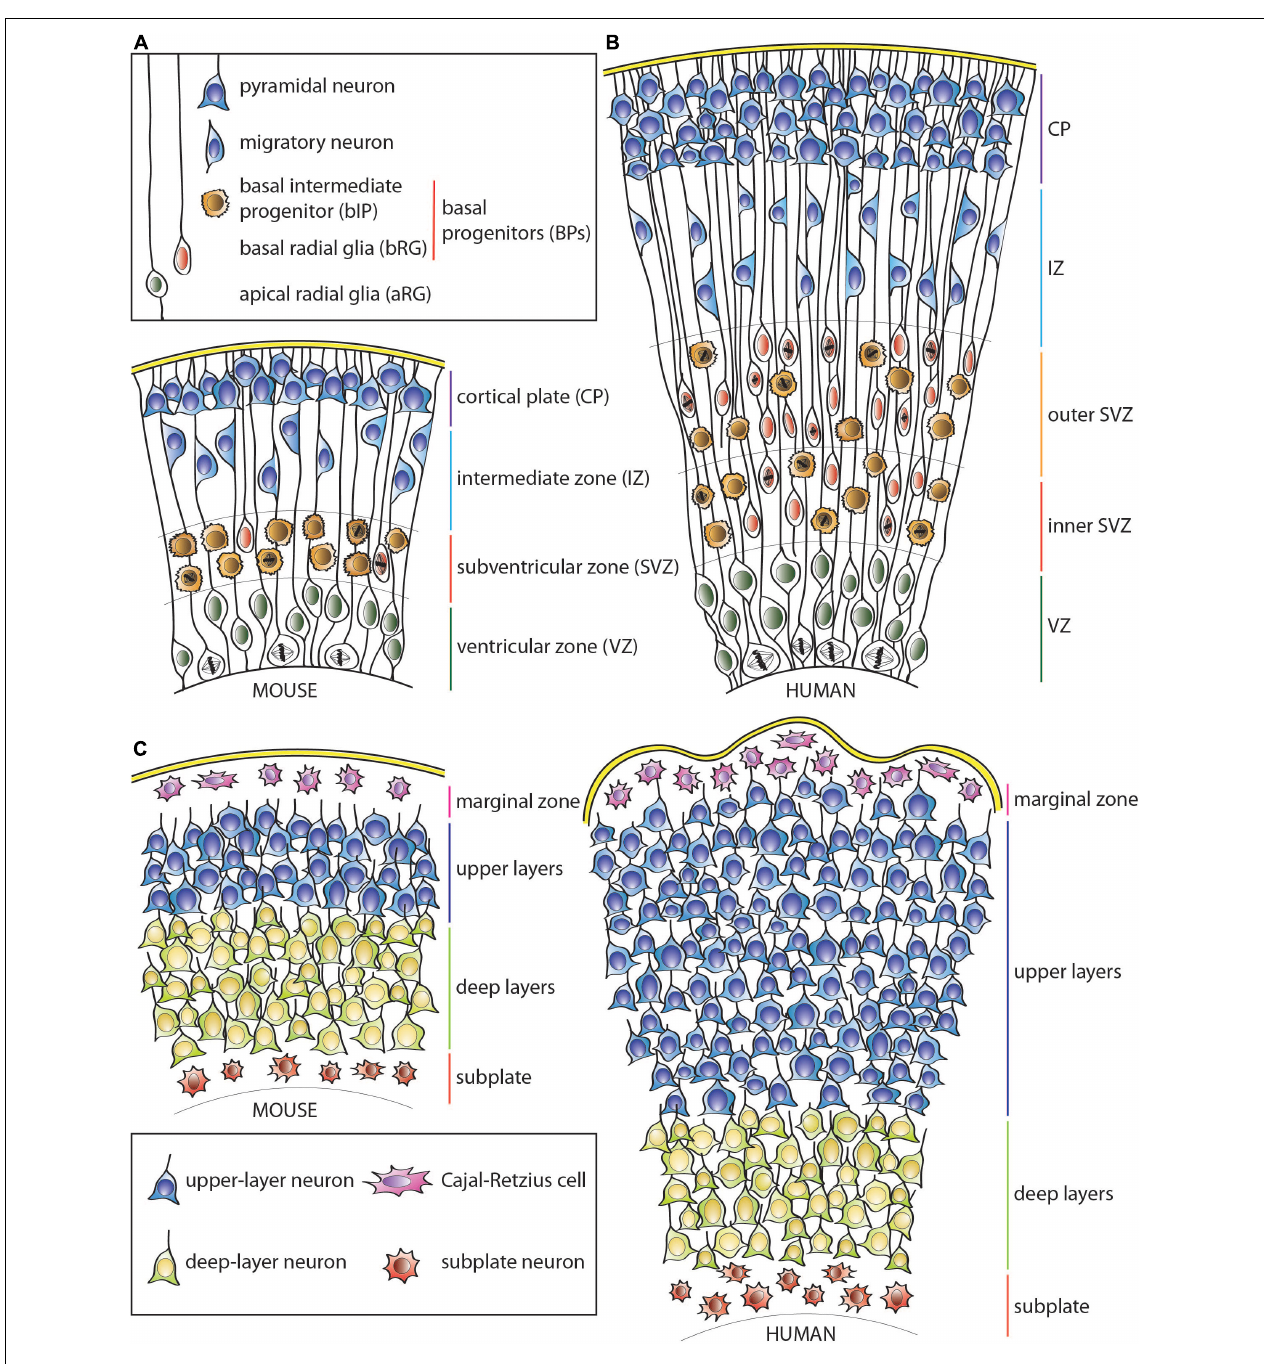
FIGURE 1 | Schematic representation of the developing neocortical wall in mouse and human. (A) Mouse neocortical wall. (B) Human neocortical wall. (C) Mouse (left) and human (right) cortical plates. Note both the tangential and radial (predominantly in the upper layers) expansion of the human cortical plate. For cell types, see keys in (A,C)